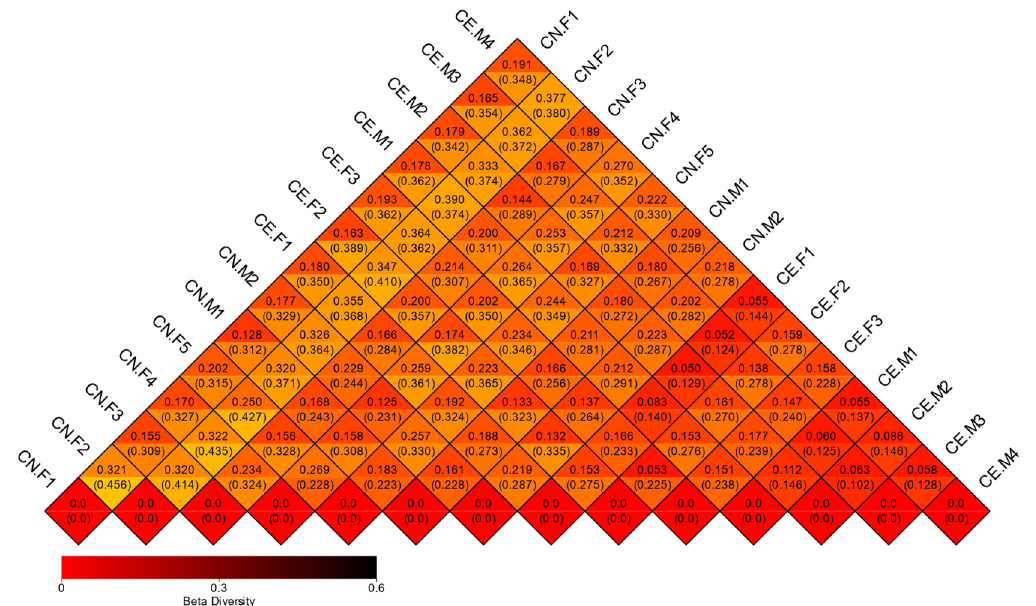
Figure 7. Heatmap of beta diversity. The numbers in the grids are the dissimilarity coefficients of the samples. The diversity of the bacterial species is proportional to the dissimilarity coefficient. The two numbers in the same grid represent weighted and unweighted Unifrac distances, respectively.